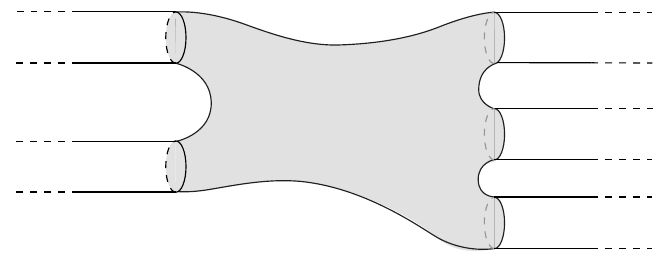
Figure 2 . A hyperbolic surface ˜Σ g,n with n boundary geodesics of length L becomes a surface Σ g,n ∈ b P g,n by attaching flat semi-infinite cylinders of circumference L at each